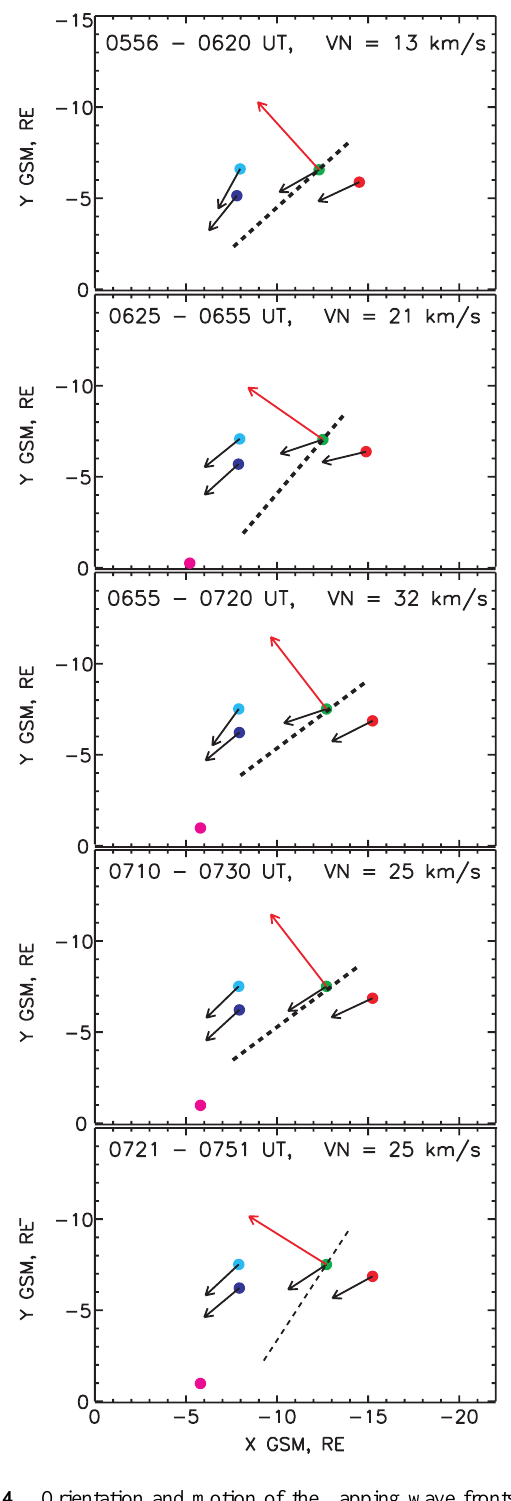
Fig. 4. Orientation and motion of the flapping wave fronts, ob- served during 06:00–08:00UT, on 20 December 2007. Black ar- rows show the magnetic field maximum variance direction, red ar- rows show the projection of the front normal velocity onto the XY plane, dashed lines show the front orientation for 5 successive